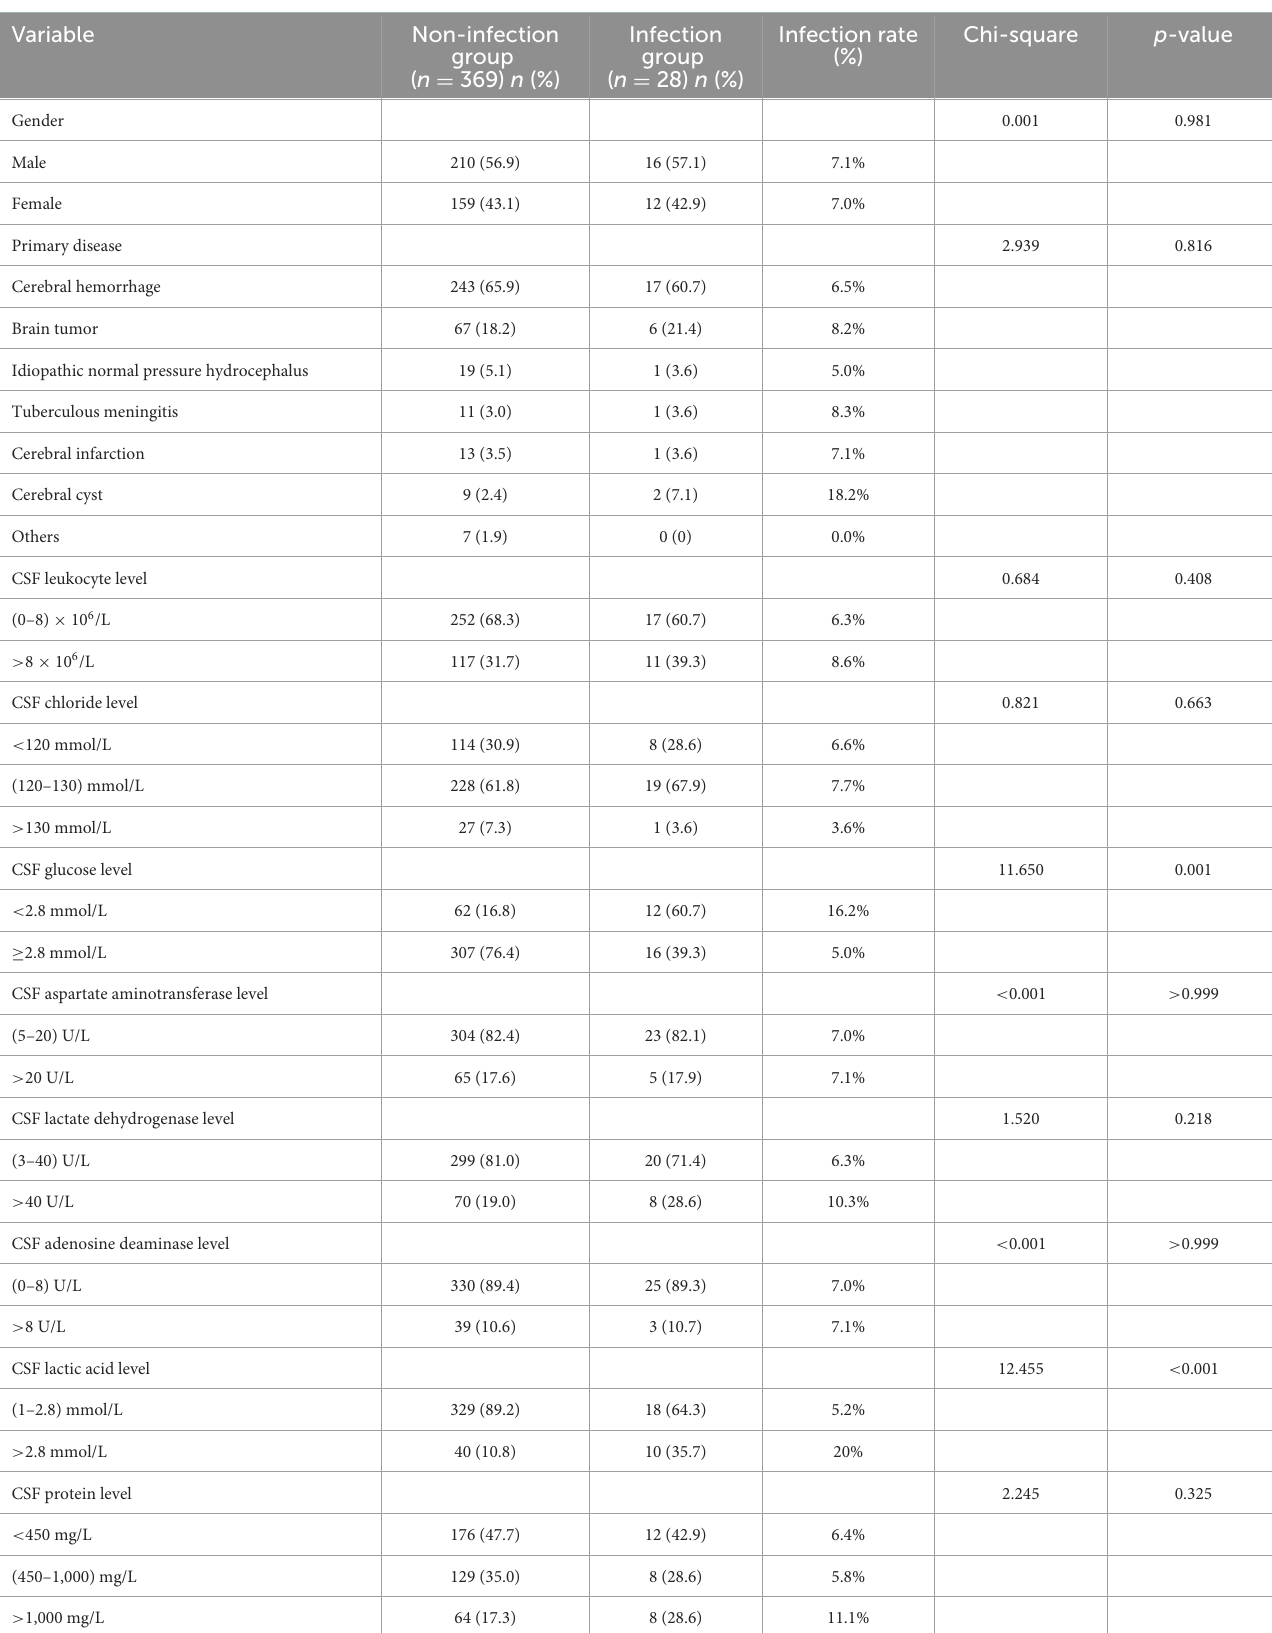
TABLE 1 Single factor analysis of the difference between the two groups in gender, primary disease and CSF